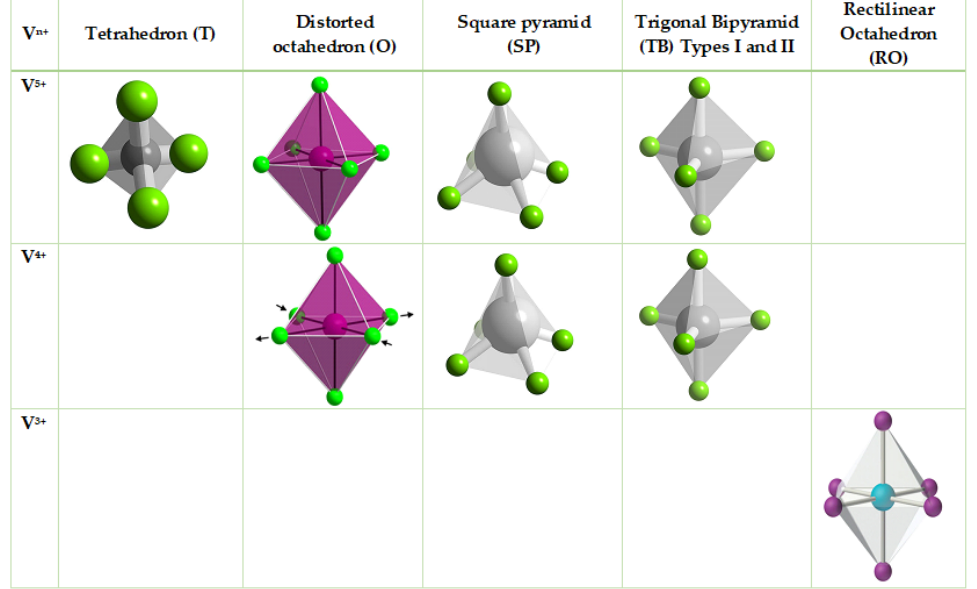
Figure 1. Different coordination in vanadium oxide open frameworks, where the V n+ ion may adopt different types of polyhedrons in different structural lattices.